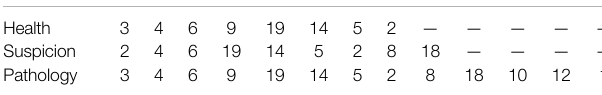
TABLE 4 | Frequent itemset attribute columns of different categories.